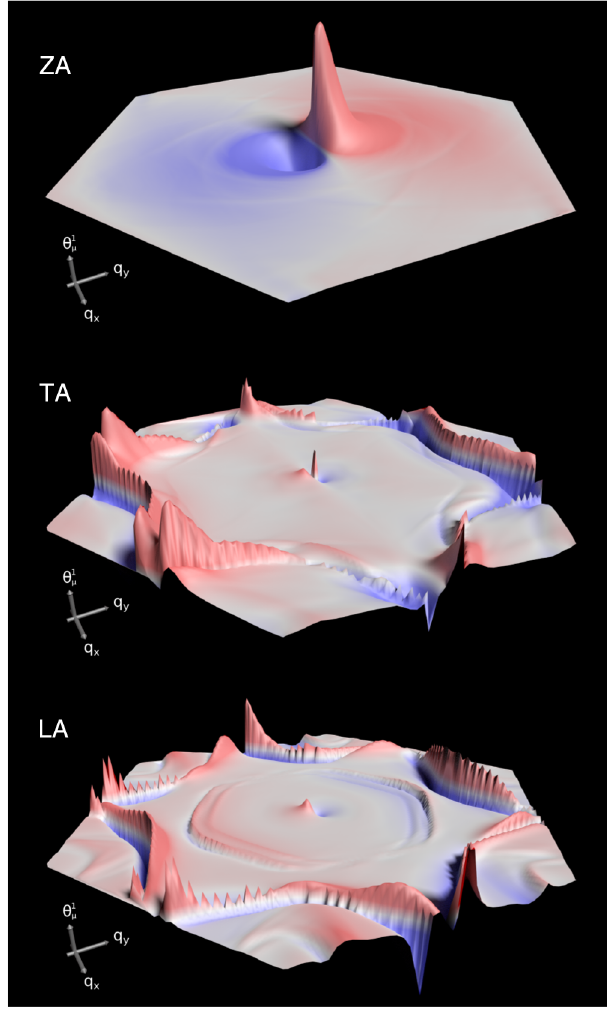
FIG. 2. Representation of the relaxon θ α μ with the longest relaxation time ( α ¼ 1 ) in graphene at room temperature as a function of the phonon index μ ¼ ð q ; s Þ , where we choose s to be the out-of-plane, transverse, or longitudinal acoustic mode (ZA, TA, and LA, respectively). We recall that the relaxon is a difference in phonon populations with respect to thermal equilibrium: Overpopulated modes are shown in red; depopulated ones are in blue. The fine structure of the ridges is a numerical artifact due to discrete Brillouin-zone